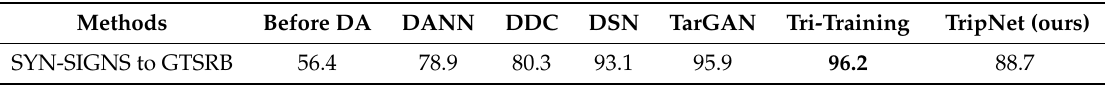
Table 3. Unsupervised domain adaptation results for the SYN-SIGNS to GTSRB experiment. The results have been directly used, as well as the results reported in the original